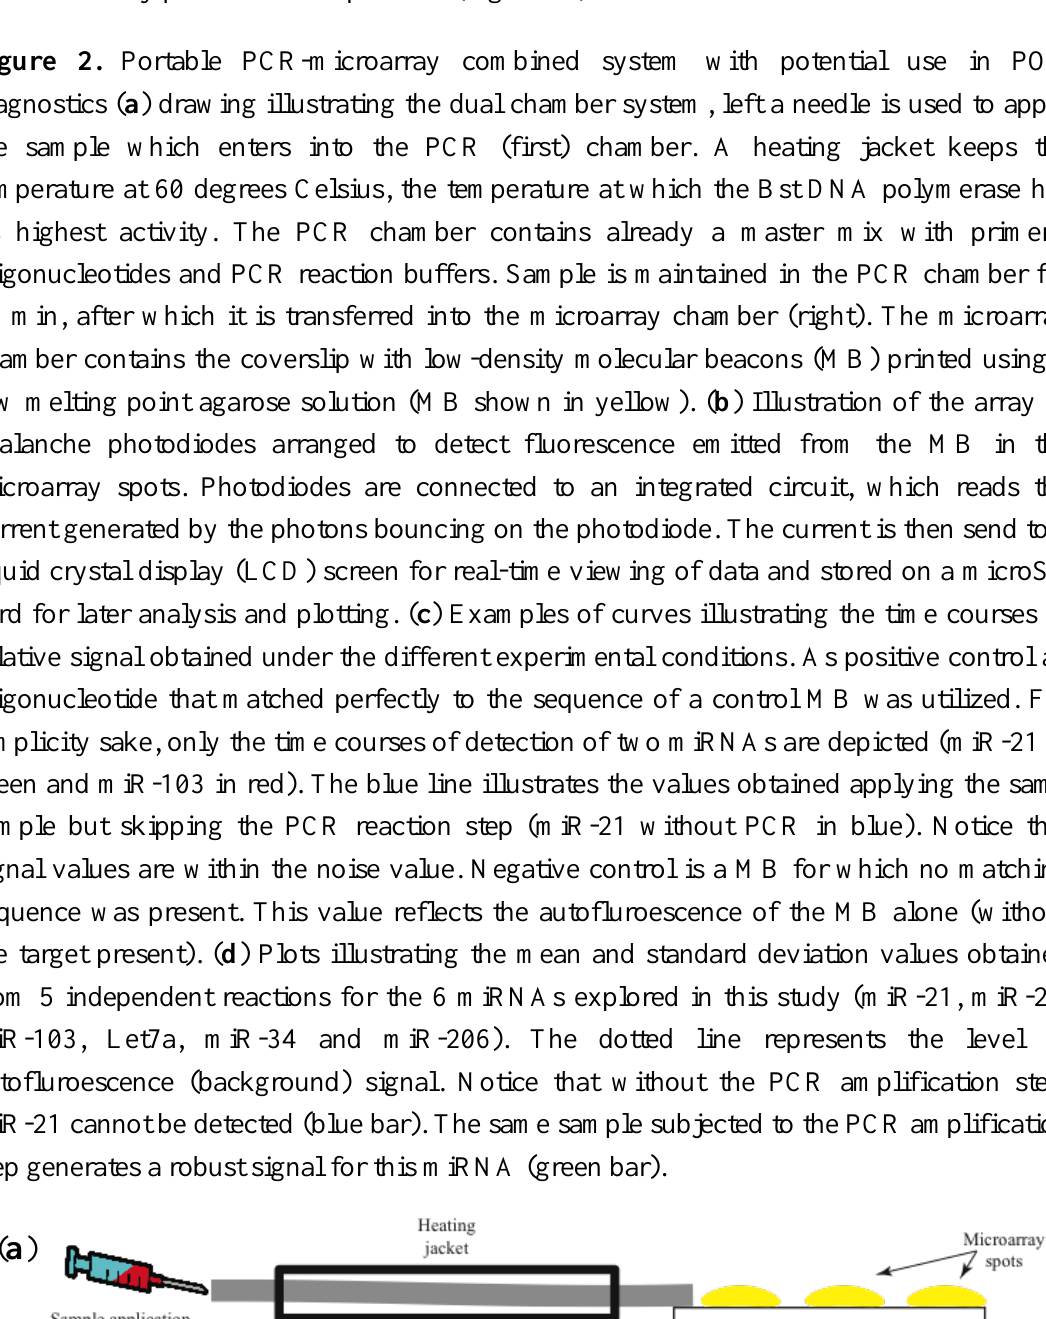
Figure 2. Portable PCR-microarray combined system with potential use in